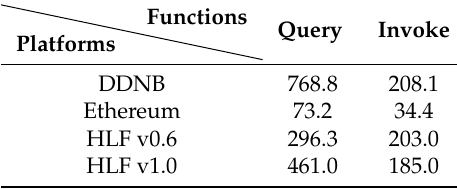
Table 3. Average TPS of various platforms for query and invoke